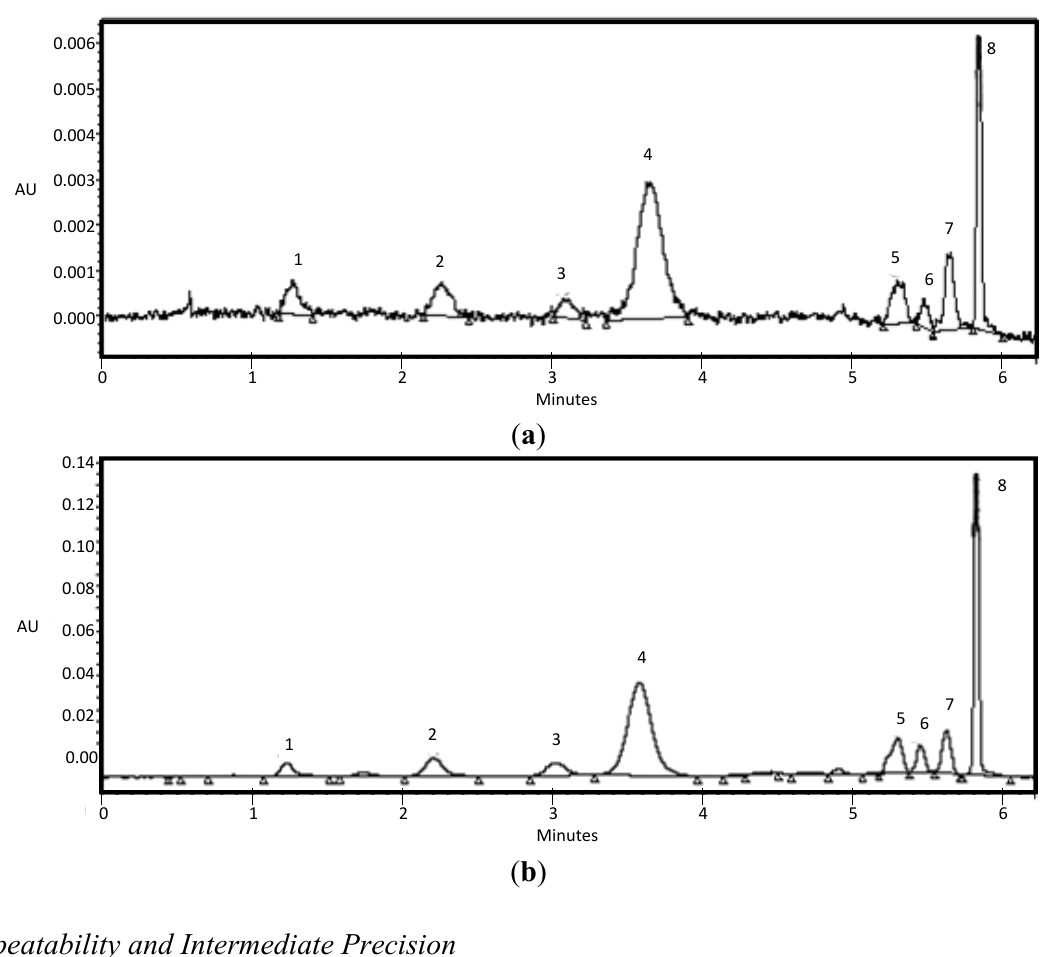
Figure 2. Chromatograms obtained before ( a ) and after ( b ) applying the optimized SPE method. 1: D3g, 2: Pt3G, 3: Pd3G, 4: M3G, 5: MAG, 6: MCafG, 7: PtCG and 8: